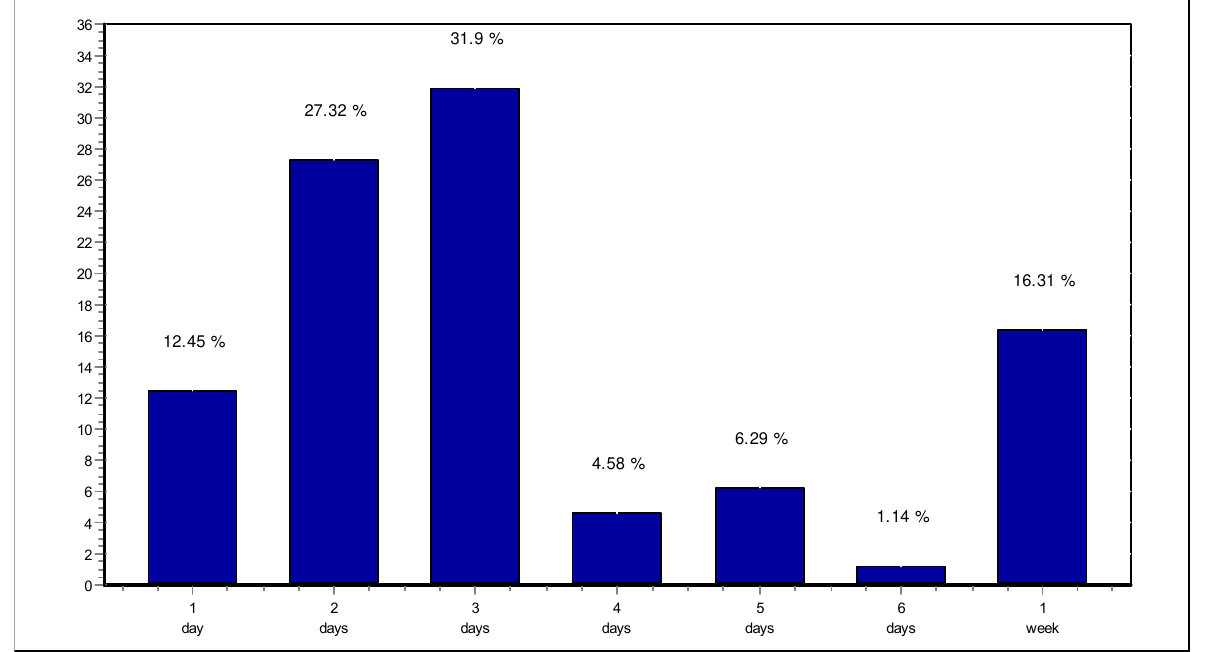
Fig. 10.Ideal duration of